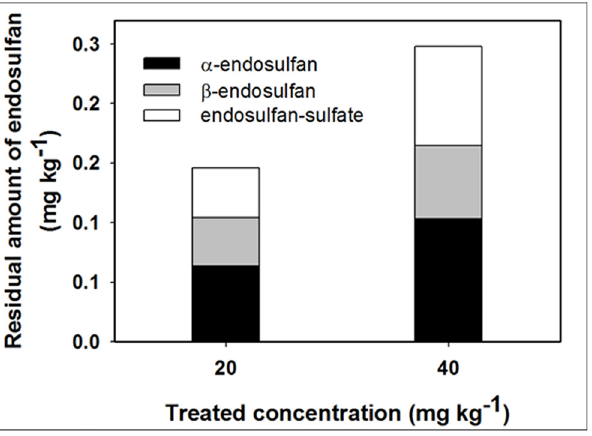
Fig 4. Distribution patterns of isomers and sulfate-metabolite of ED absorbed from the soil into cucumbers grown for 120 d under greenhouse conditions.